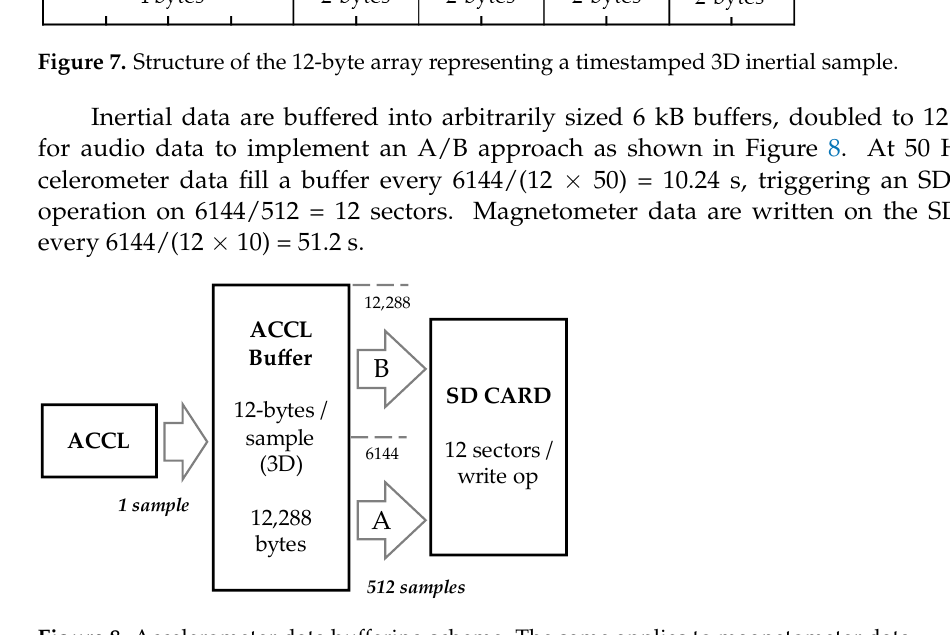
Figure 8. Accelerometer data buffering scheme. The same applies to magnetometer data.